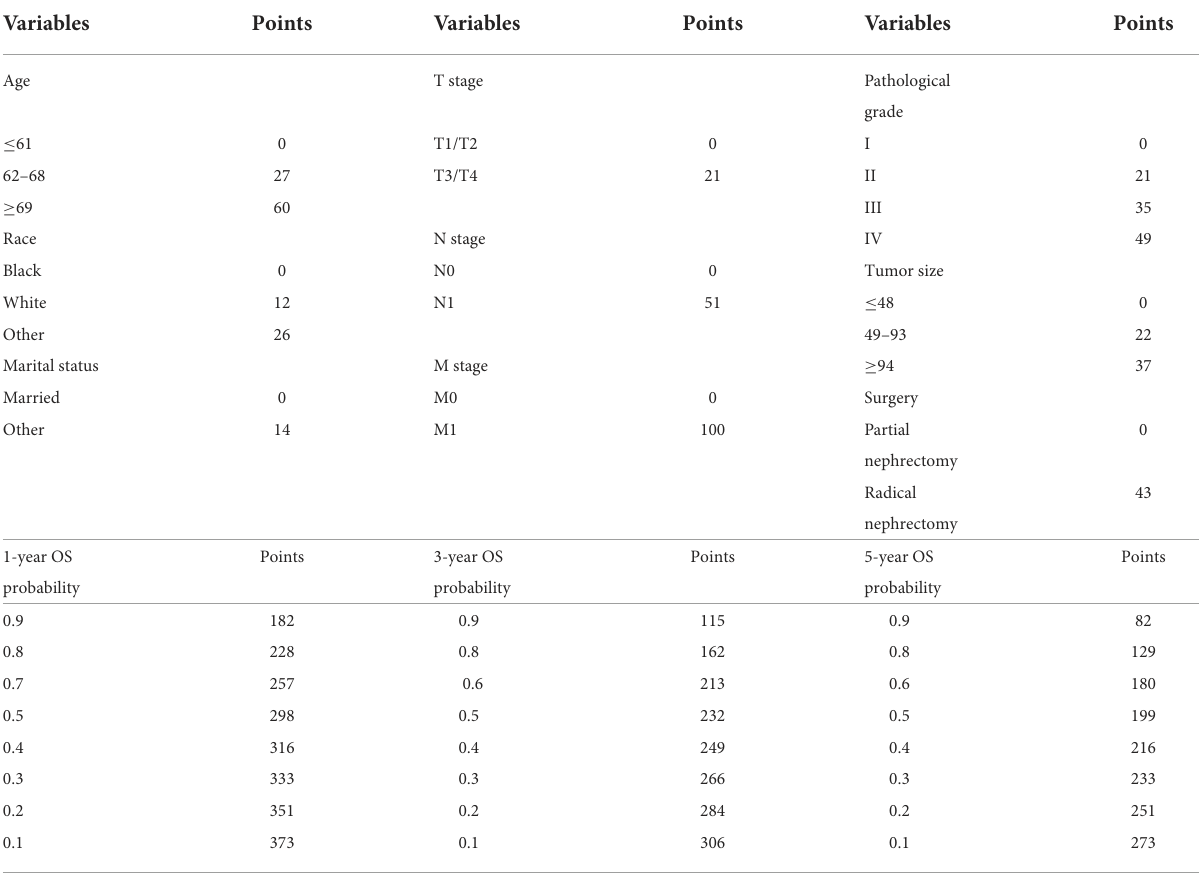
TABLE 3 Nomogram scoring system. Variables Points Variables Points Variables Points